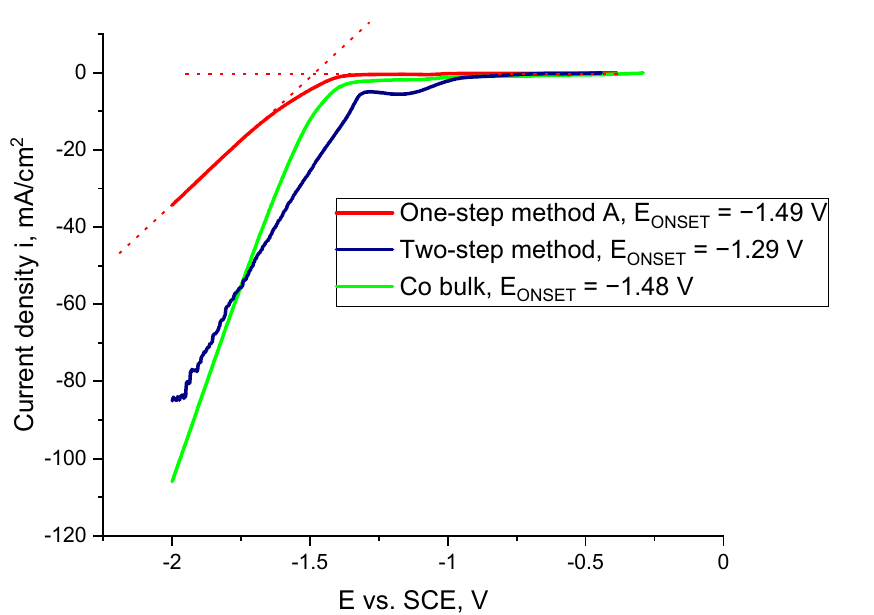
Figure 4. Linear sweep voltammetry (LSV) curves of Co bulk and Co nanocones obtained using one-step and two-step method in 1 M NaOH solution.